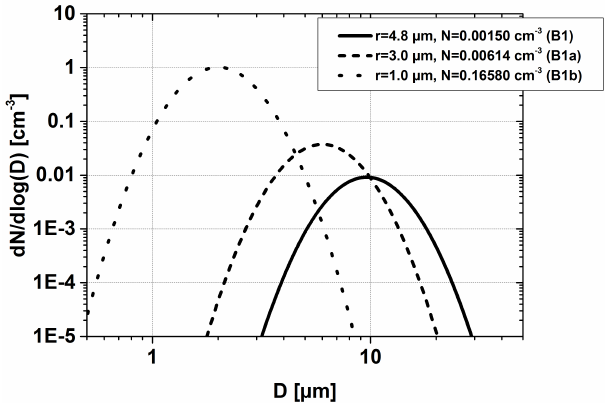
Figure B1. Size distributions used for sensitivity simulations dis- cussed in Appendix B. The total volume of condensed β -NAT is constant (corresponding to 8.4ppbv of gas-phase equivalent HNO 3 ) and the mode width is 1.35 in all cases. For the binned size distribu- tion used in the AR = 0.1 scenario with r = 1 . 0, the particle number density had to be scaled to 0.17342cm − 3 to match 8.4ppbv of gas- phase equivalent HNO 3